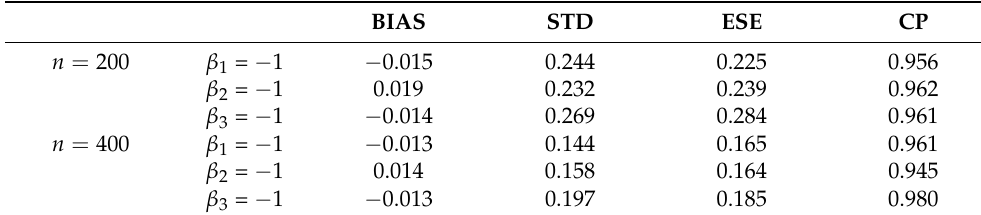
Table 2. Simulation results for ( β 10 , β 20 , β 20 ) = ( − 1, − 1, − 1 ) . BIAS STD